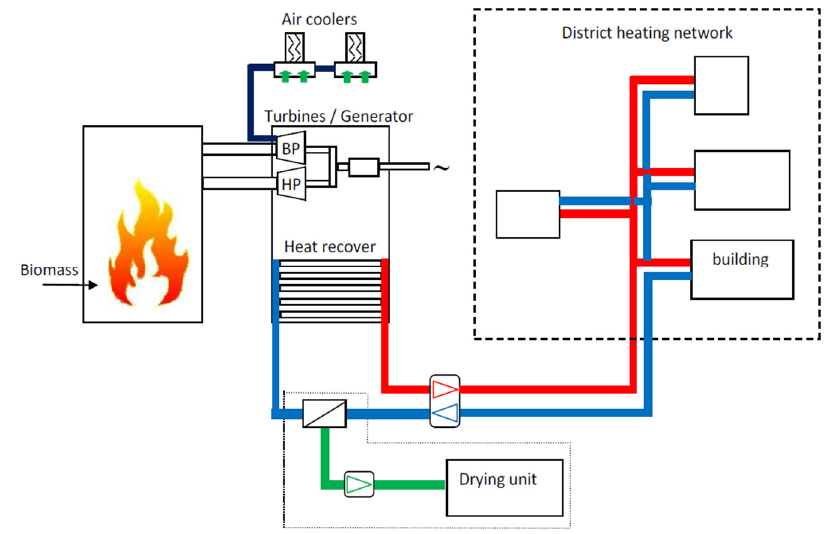
Figure 1. Schematic diagram of the cogeneration facility.